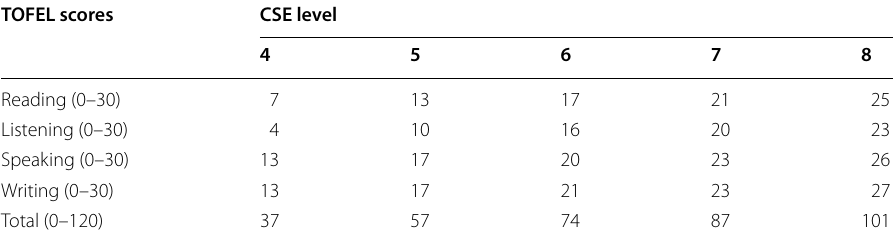
The Chinese English Proficiency Scale is divided into nine levels from low to high. The study focused on levels four through eight of the scale TOEFL test scores are reported separately according to reading, listening, speaking, and writing, and the score range of each section is 0–30 points, and the total score is 0–120 points The Table presents the critical scores of the relevant grades of each section of the TOEFL test and the total score corresponding to the scale. Example: If the TOEFL reading score is 7 points, it will reach the scale level 4; If you get 13 points for reading, you will reach the level of level 5 of the scale; If you score 12 points, you are still at the scale level four Because the total score of the TOEFL is the sum of the grades of each part, the critical score of the total score in this corresponding Table is the sum of the critical scores of each